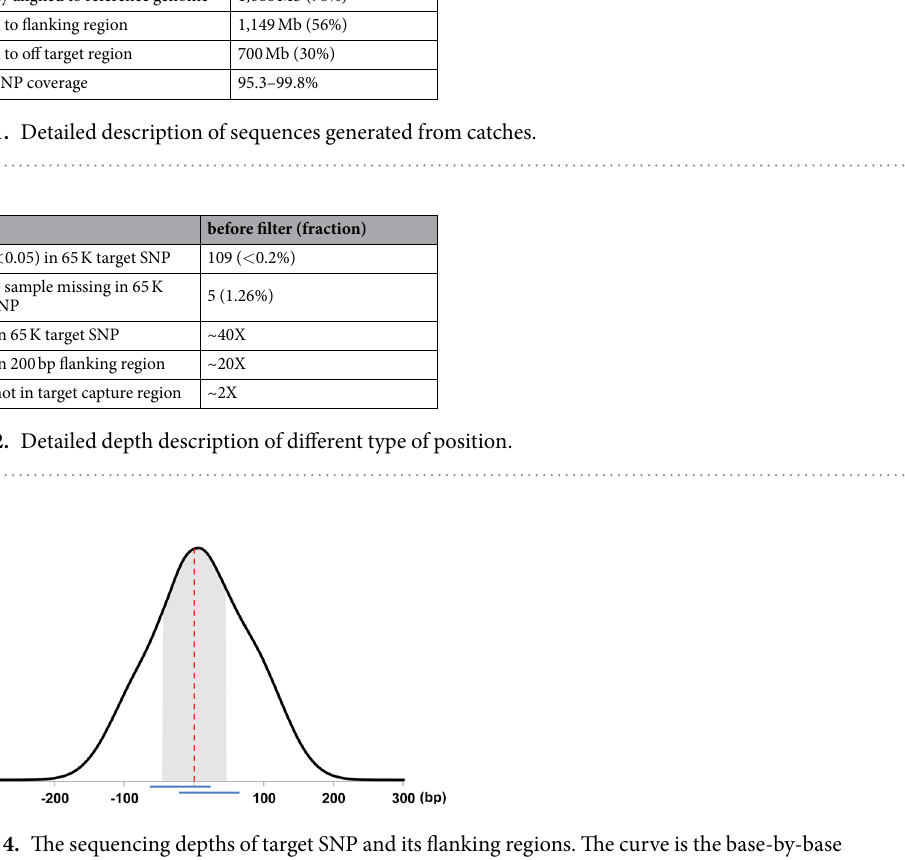
Figure 4. The sequencing depths of target SNP and its flanking regions. The curve is the base-by-base sequencing coverage around the target SNP. The probes are marked as the horizontal blue bars. The red dashed line in 0 position indicated the target SNP location.